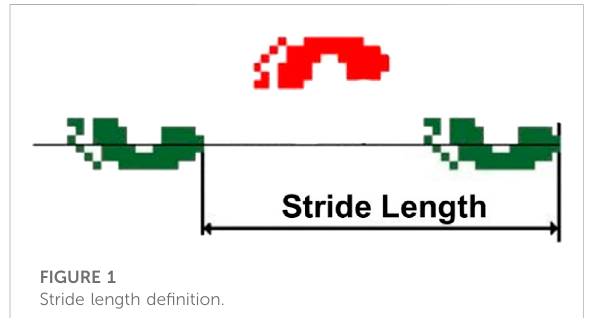
FIGURE 1 Stride length de fi